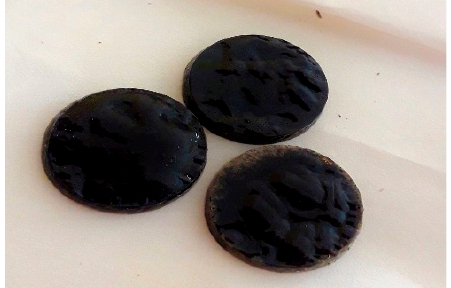
Figure 9. Polystyrene/AP Sludge composites.